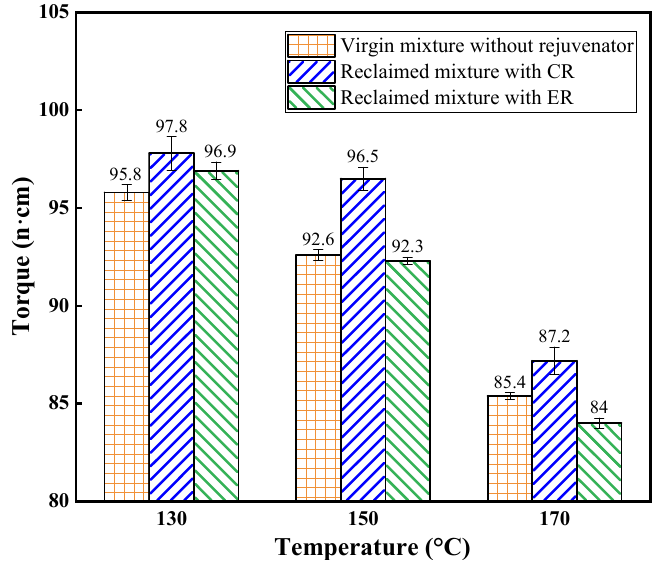
Figure 5. Torque values of asphalt mixtures at different mixing temperatures.